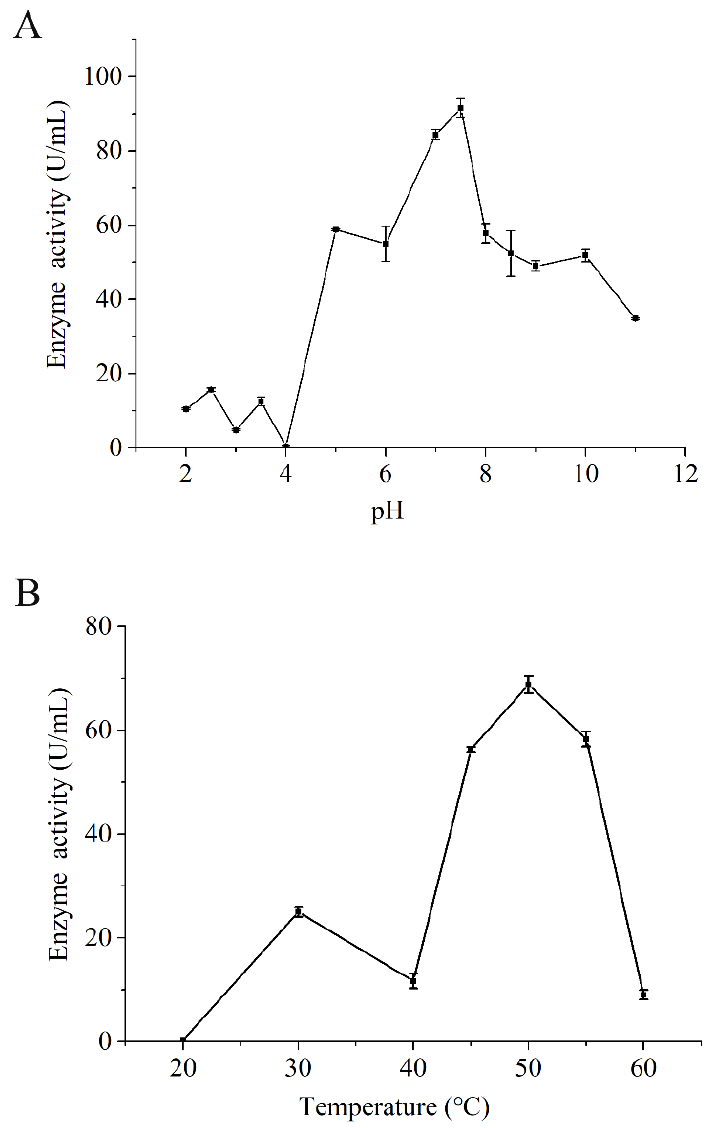
Figure 6. The effects of ( A ) pH and ( B ) temperature for the endogenous protease. Table 5. A summary of the purification of endogenous protease on the extract from shrimp heads.